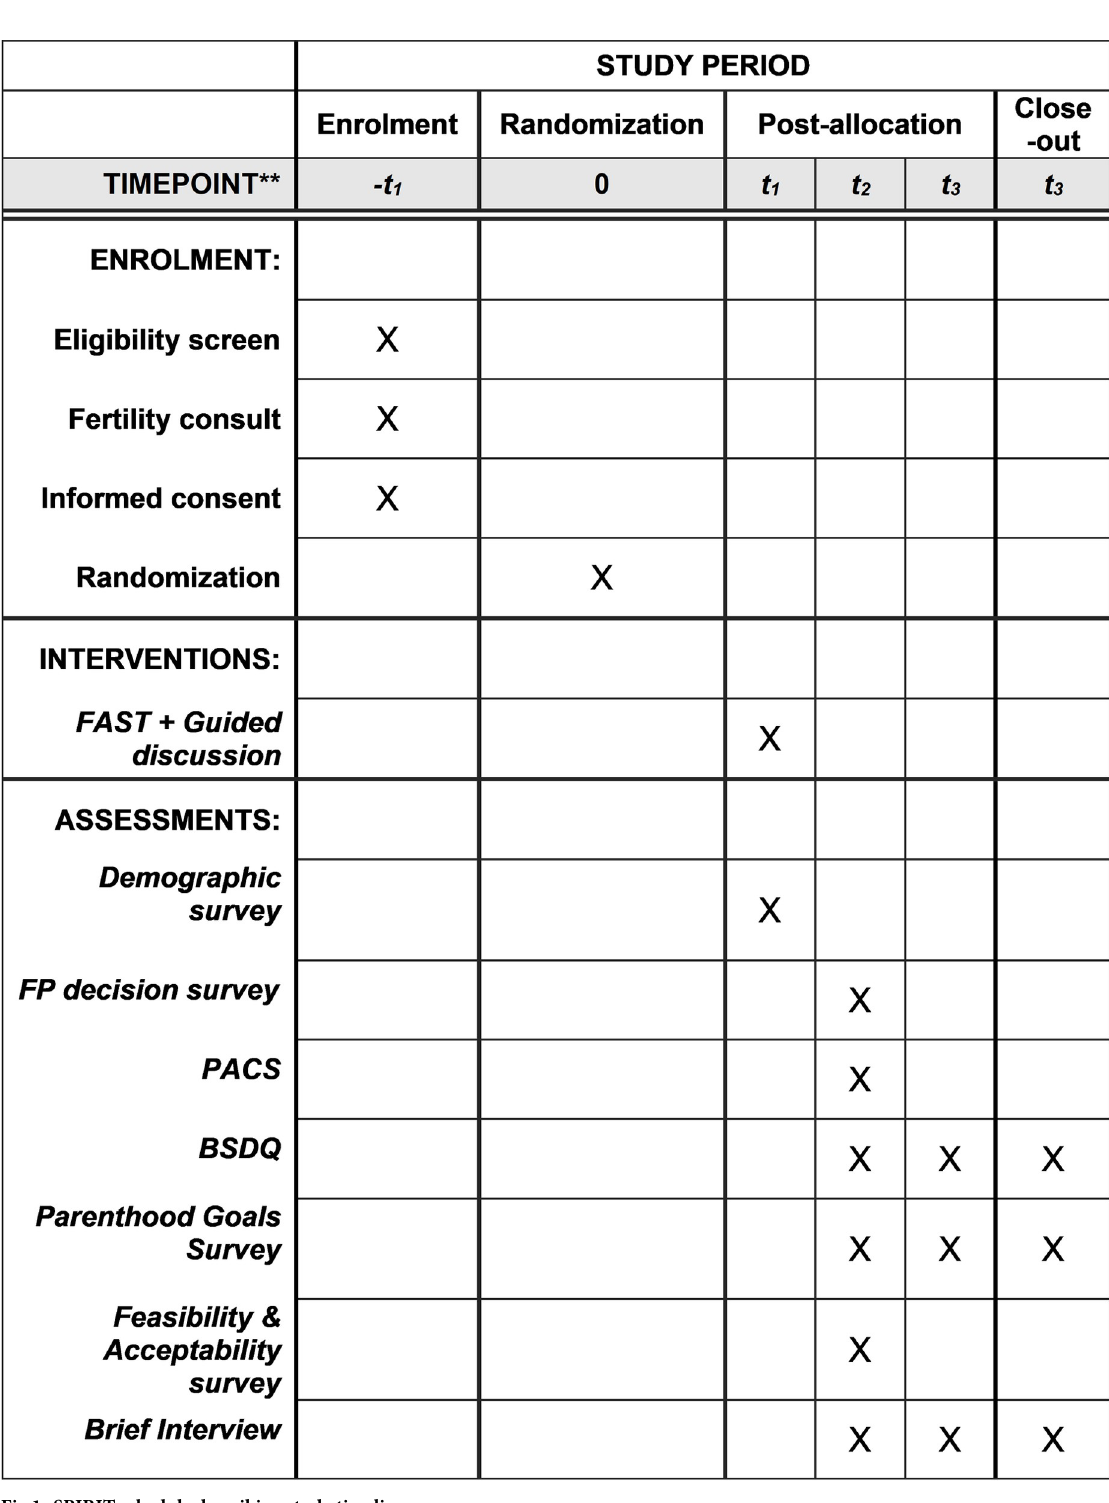
Fig 1. SPIRIT schedule describing study